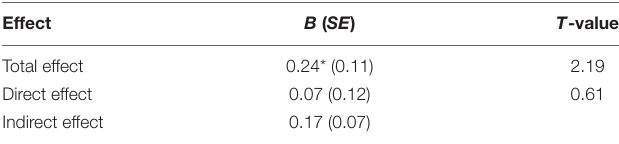
TABLE 4 | Results of teachers’ emotional support as a predictor of mastery orientation, mediated by competence beliefs.